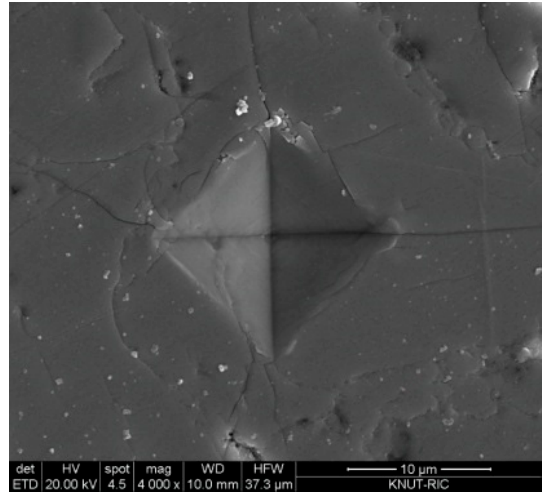
Figure 4. SEM image showing the indentation left due to diamond shaped tip in Vickers microhardness test.